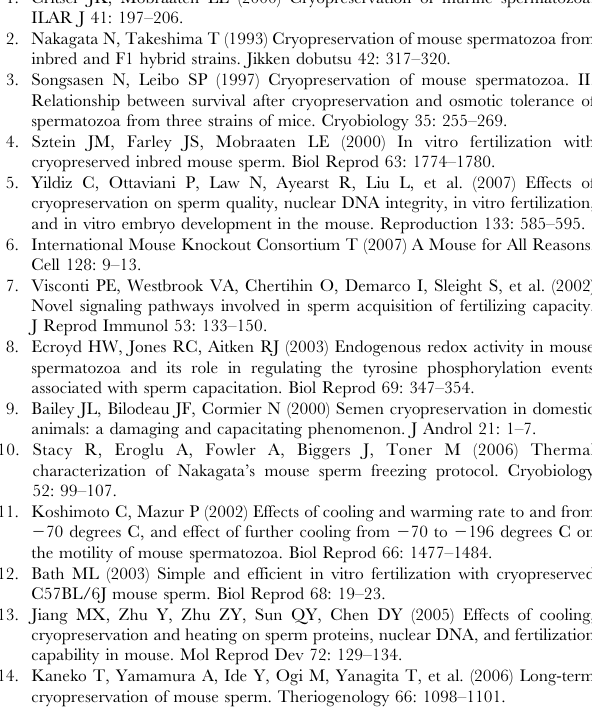
Table S1 Data set for sperm cryopreserved and recovered using new method and freshly transferred embryos.